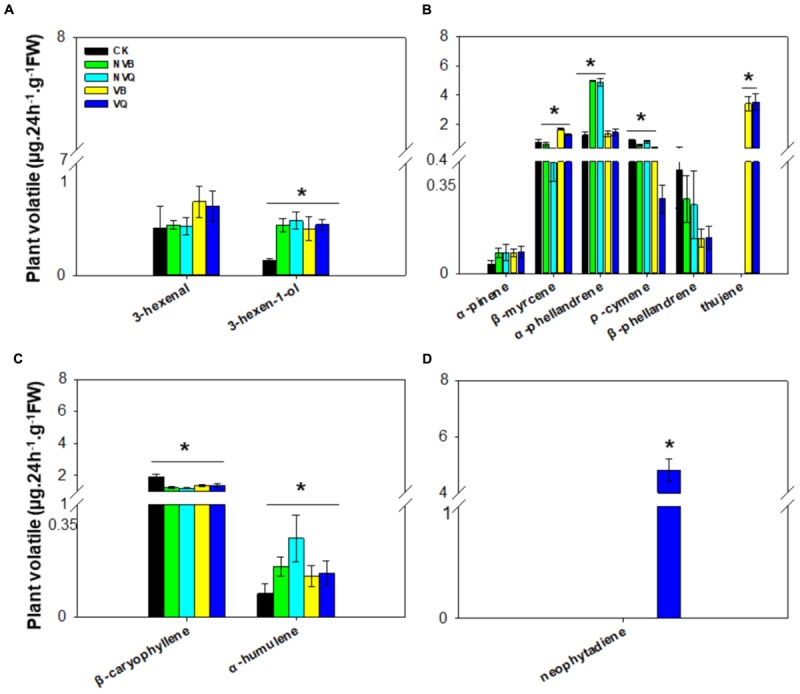
Volatiles generated from non-infested and infested host plants with non-viruliferous and viruliferous MEAM1/B and MED/Q. (A) Aliphatic compound (in the order of 3-hexenal and 3-hexen-1-ol); (B) Monoterpene (in the order of α-pinene, β-myrcene, α-phellandrene; ρ-cymene; β-phellandrene and thujene); (C) Sesquiterpene (in the order of β-caryophyllene and α-humulene); (D) Diterpene (neophytadiene). CK: Plants were non-infested. NVB: Plants were infested with non-viruliferous MEAM1/B. NVQ: Plants were infested with non-viruliferous MED/Q. VB: Plants were infested with viruliferous MEAM1/B. VQ: Plants were infested with viruliferous MED/Q. All plants were infested with 300 B. tabaci 2 days before volatile trapping. Values are means ± SE (n = 9). Asterisks indicate significant differences (P < 0.05) between the control volatiles and whitefly-infested volatiles by Tukey’s HSD test.